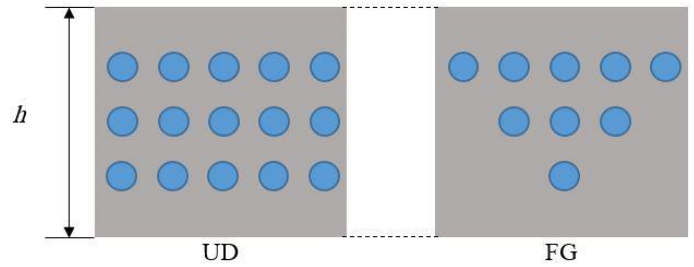
Figure 2. Distribution schemes of CNTs along the thickness direction. UD = uniform distribution; FG = functionally graded.